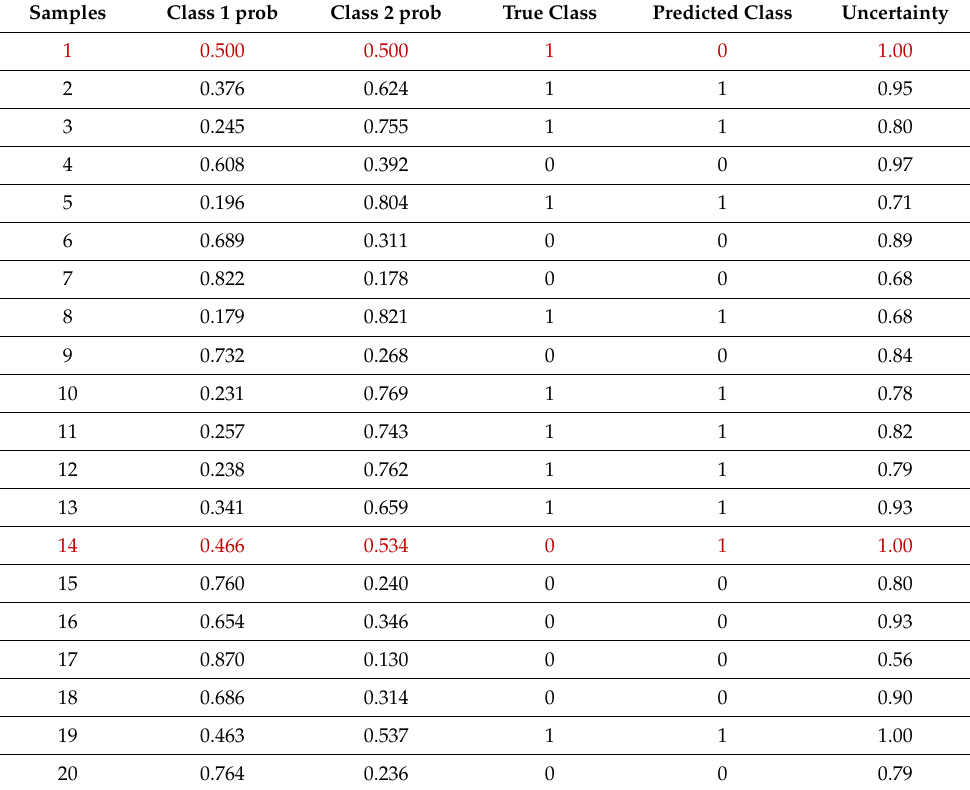
Table 3. Test predictions, prediction probability and uncertainty for GPR model with PCA. The misclassified samples are highlighted in